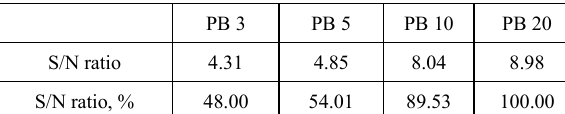
Fig. 4. Testing of the Power Bin mode profile.